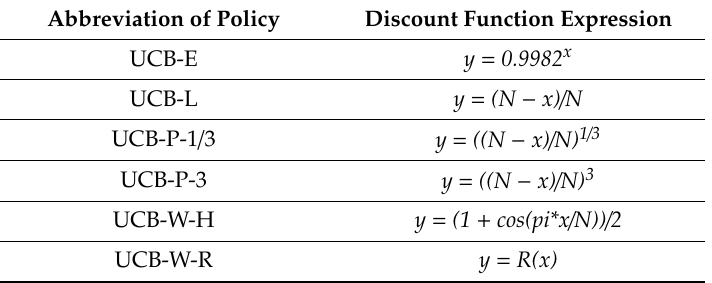
Table 2. The correspondence between the abbreviation of policy and the discount function